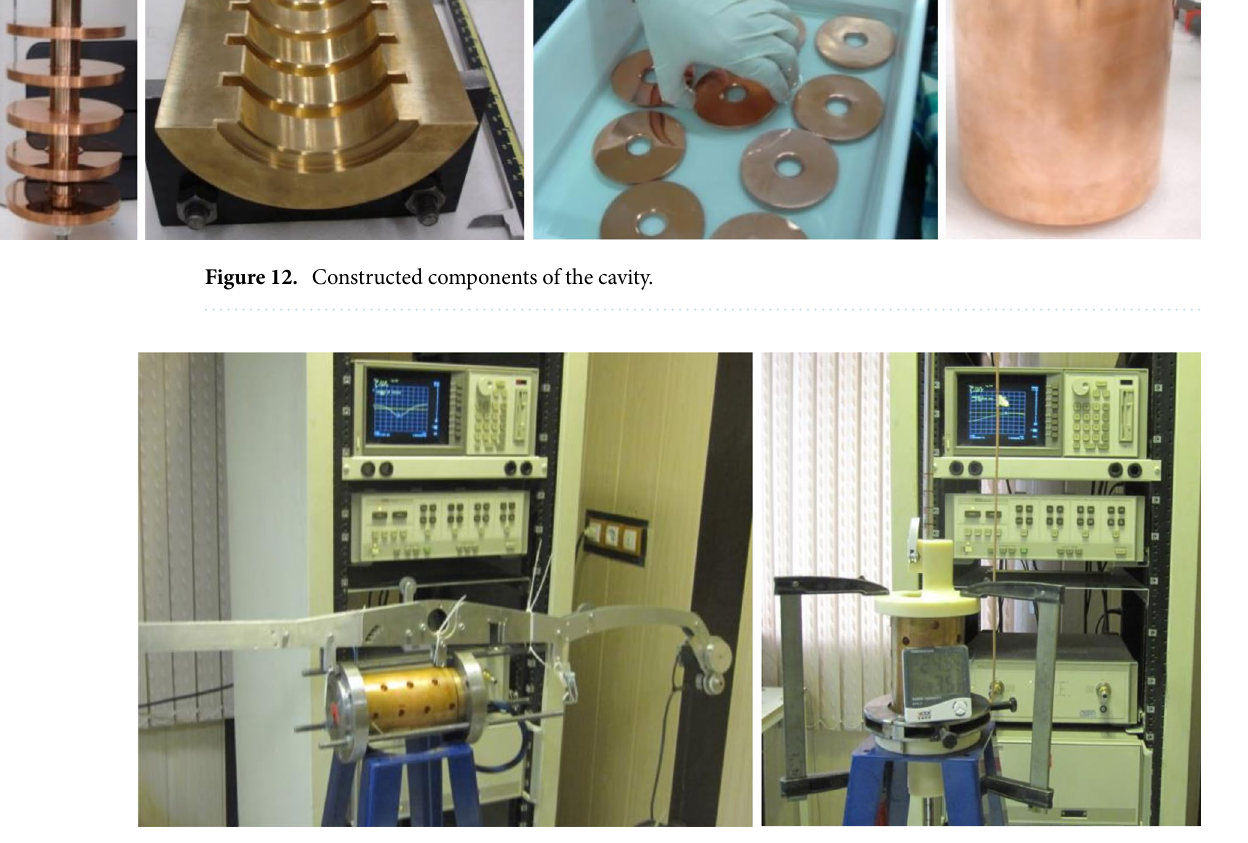
Figure 13. Bead-pull measurement and tuning setup.